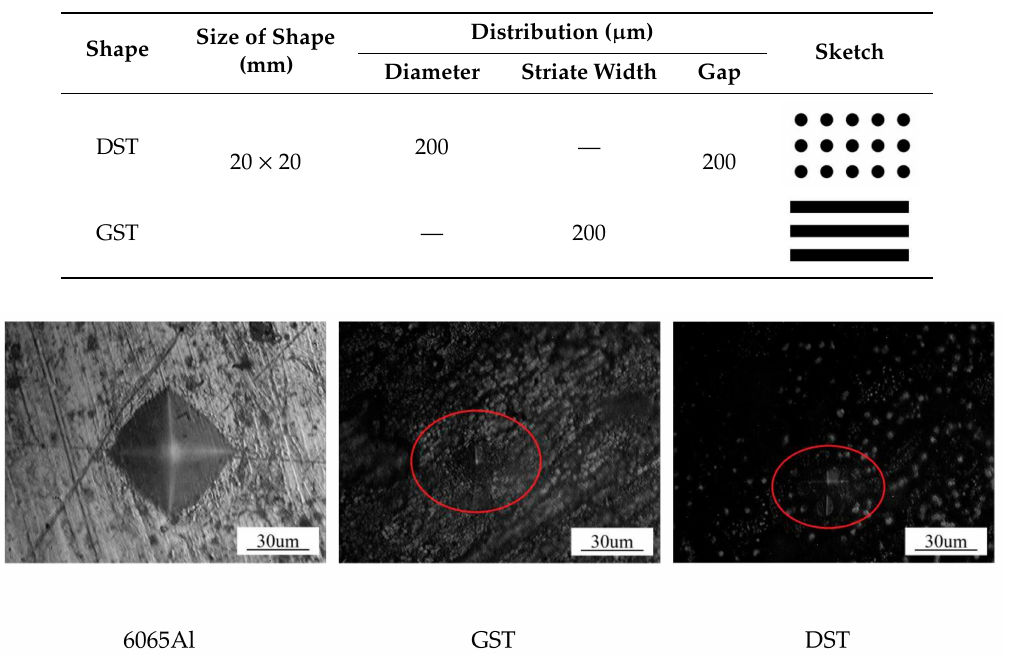
Table 2. Parameters of dimple and groove texture. DST: dimple surface texture; GST: groove surface texture.